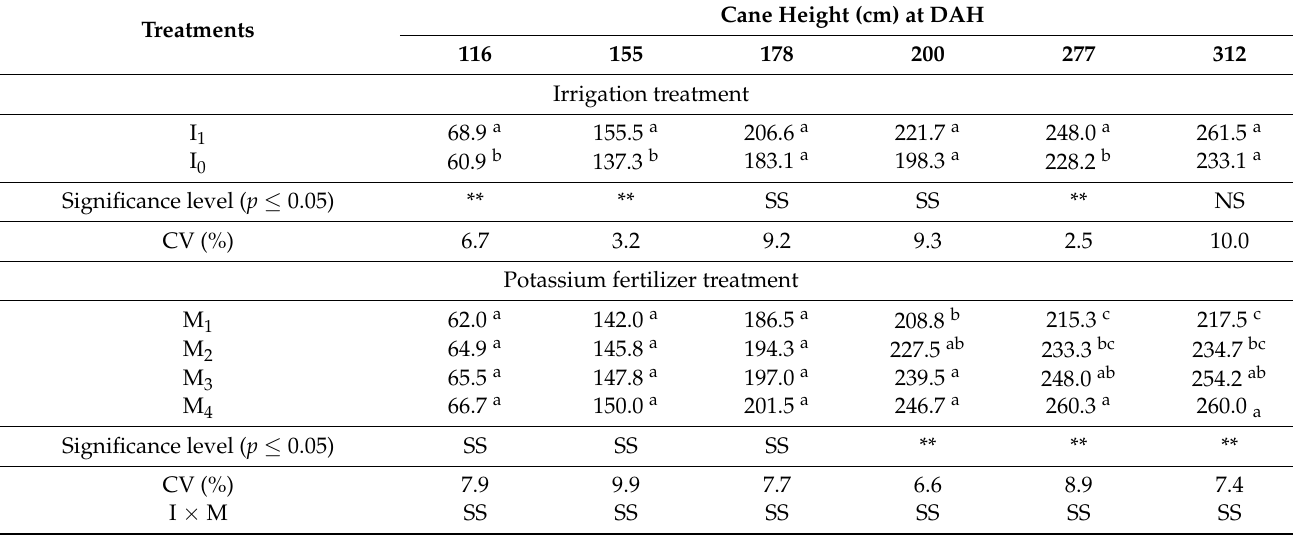
Table 1. Average sugarcane height under irrigation and potassium